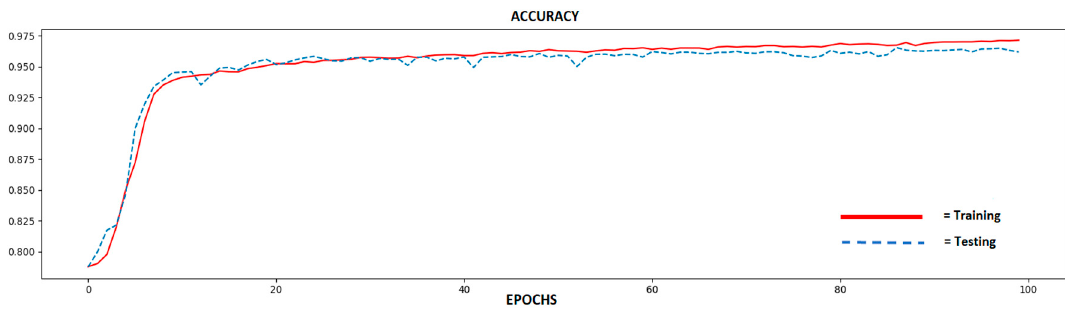
Figure 6. The plot of accuracy of the LSTM architecture with 90% of training and 10% of testing set.